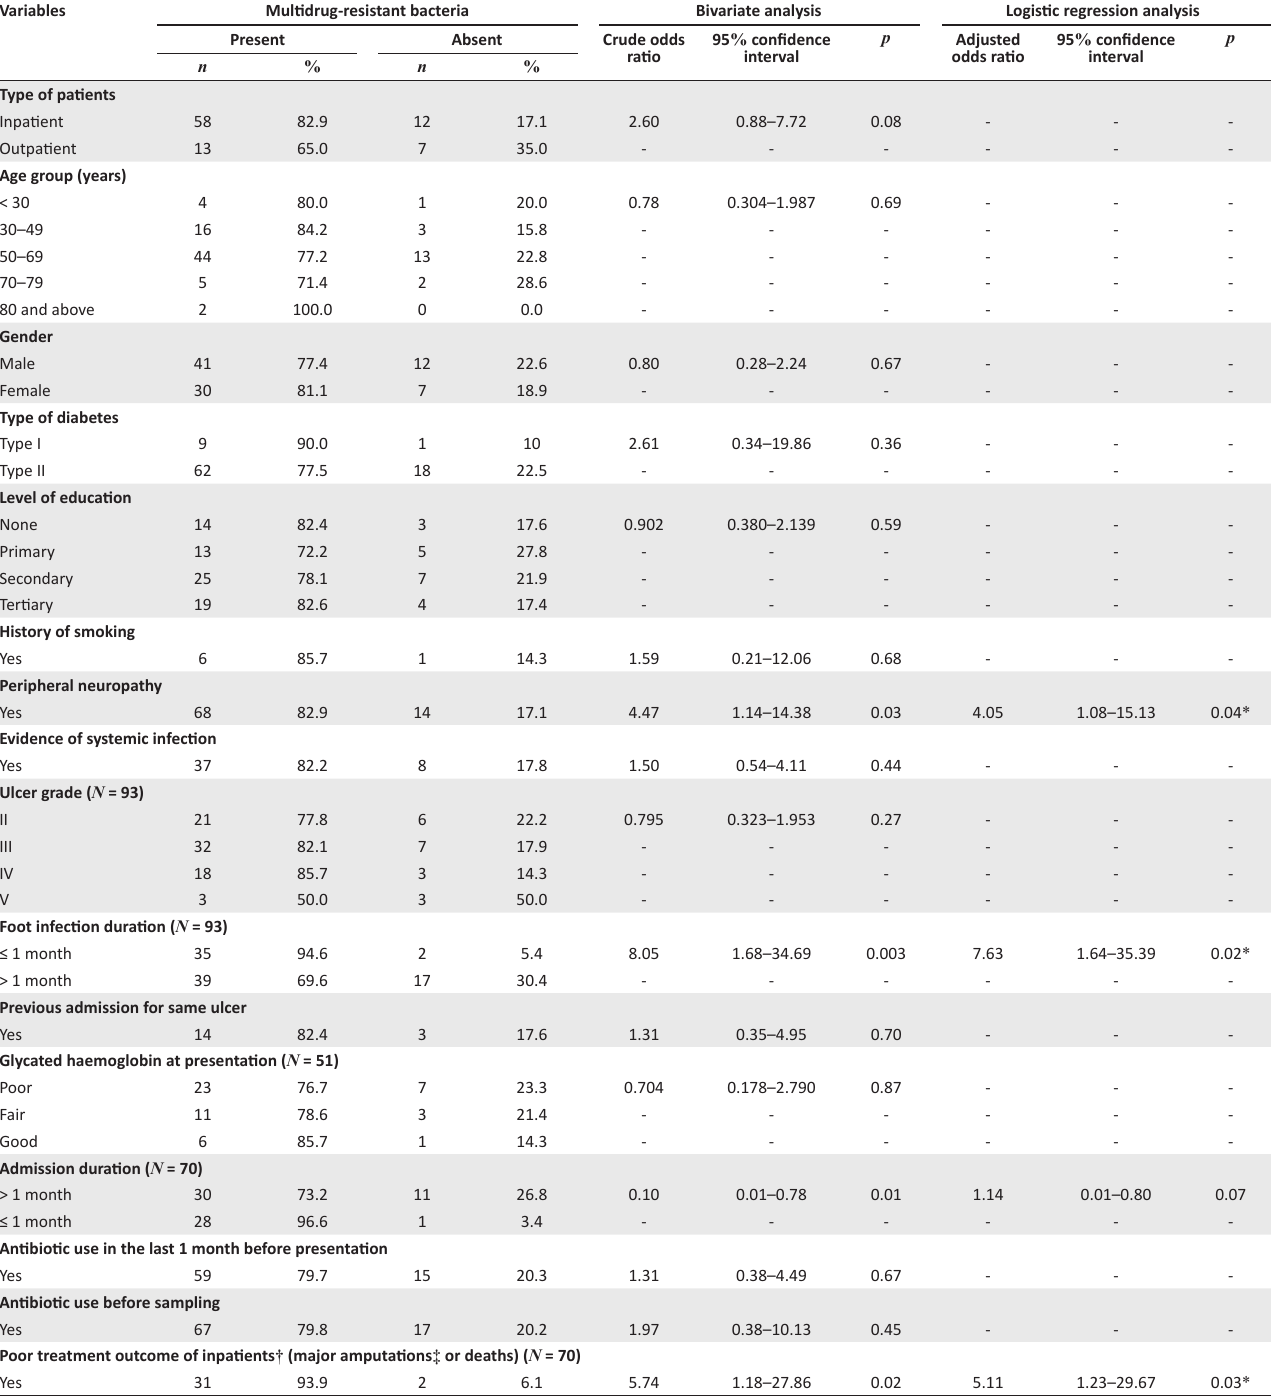
TABLE 2: Association between clinical and sociodemographic variables of infected diabetic foot ulcer patients from tertiary healthcare facilities in Osun state, Nigeria, July 2016 to April 2017.